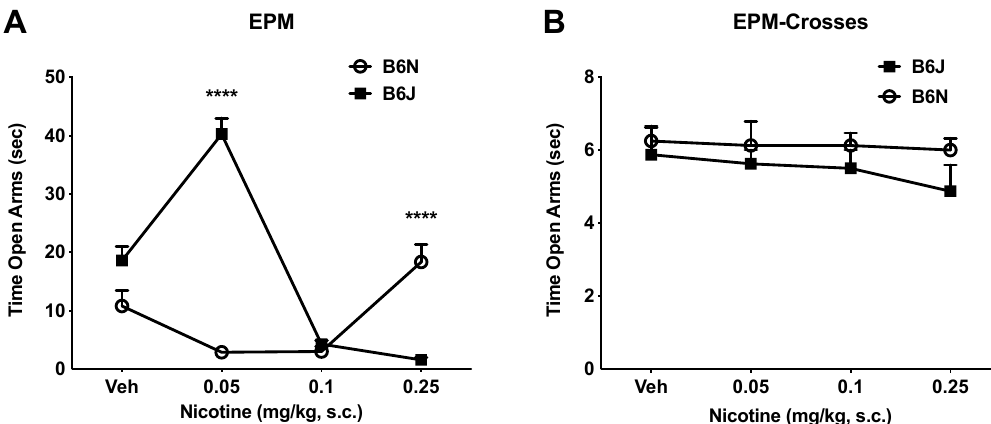
Figure 2. The effects of acute nicotine on anxiety-like behaviors in B6J and B6N substrains. In the B6J strain, mice receiving a lower dose of nicotine (0.05 mg/kg) spent more time in the open arms of the elevated plus maze than mice receiving higher doses (0.1 and 0.25 mg/kg), indicative of anxiolytic-like behavior. In stark contrast, B6N mice show no preference for the open arms of the EPM at 0.05 or 0.1 mg/kg. Only at the highest dose (0.25 mg/kg) do they show a significant increase in the time spent in the open arm of the EPM. There was no effect of nicotine on the total numbers of crosses between arms to suggest non-specific effects of nicotine on locomotion. The data are reported as mean + SE. Each data point is representative of the averaged mouse response at the given dose. Significant difference is based on Holm-Sidak post hoc test following two-way ANOVA between both substrains (**** p < 0.0001), n = 8/group.